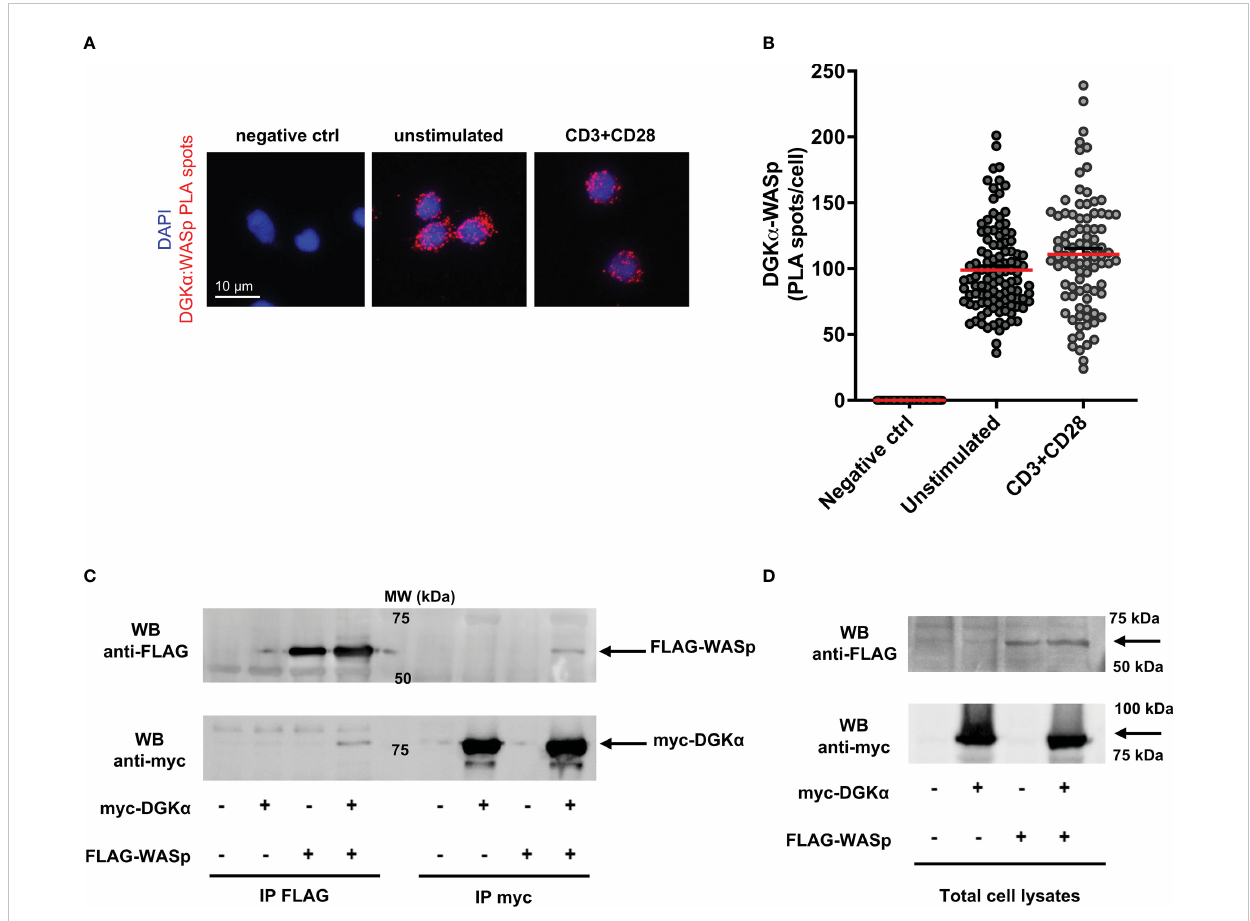
FIGURE 4 DGK a and WASp associate in a complex (A) Isolated human PBLs were seeded on poly-L-lysine coated glasses and stimulated for 15 minutes with anti-CD3 (UCHT1 10 m g/ml) and anti-CD28 (CD28.2, 5 m g/ml) antibodies, fi xed, and permeabilized. PLA was performed to assess DGK a and WASp proximity; representative images are shown. (B) Quanti fi cation of the spots/cell resulting from PLA of two independent experiments are shown with mean ± SEM (n = 60 negative control; n = 109 unstimulated; n = 90 CD3+CD28). (C) Myc-DGK a and FLAG-WASp were co-expressed in 293T cells. After 48 hours, lysates were immunoprecipitated with either anti-FLAG (left side) or anti-myc (right side) antibodies. Immunoprecipitated proteins were analysed by western blotting with anti-FLAG antibody (upper panel) followed by anti-myc antibody after stripping (lower panel). The bands corresponding to FLAG-WASp and myc-DGK a are highlighted by black arrows. A representative experiment is shown out of three. (D) Total cell lysates from experiments shown in (C)